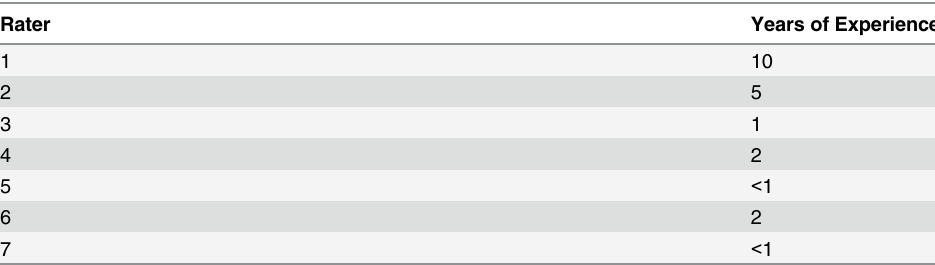
Table 1. Description of raters.